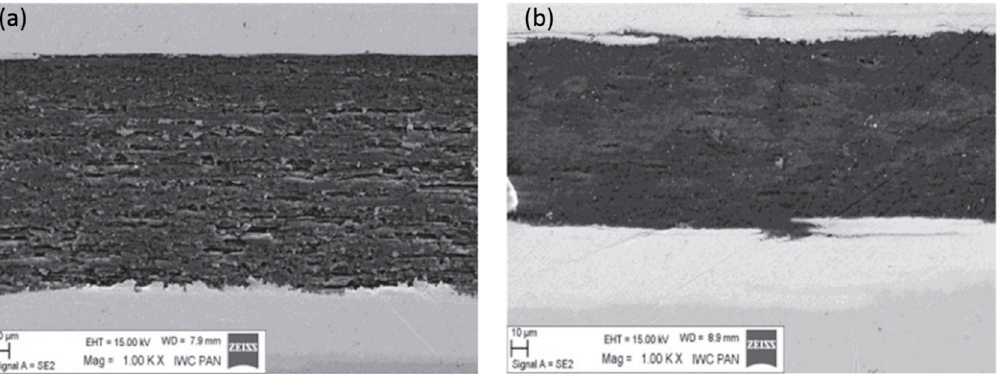
Figure 6. Comparison of SEM micrographs of ( a ) a normal-pressure filament and ( b ) an HIP filament [40]. Adapted with permission from Ref. [40]. 2014, IOP Publishing.